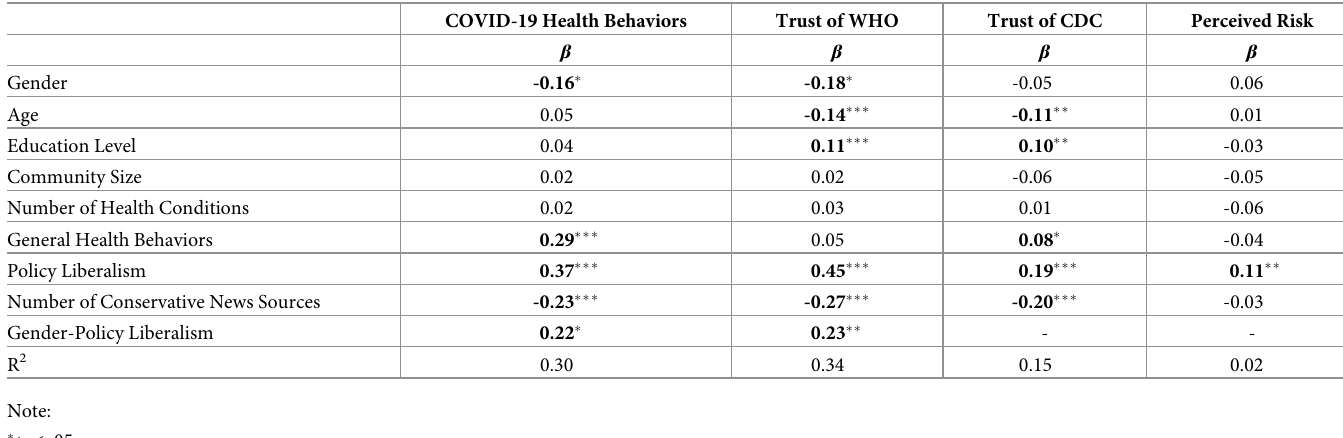
Table 3. Standardized estimates from regression analysis for pandemic-specific health behaviors, perceived risk, and trust of the scientific community.